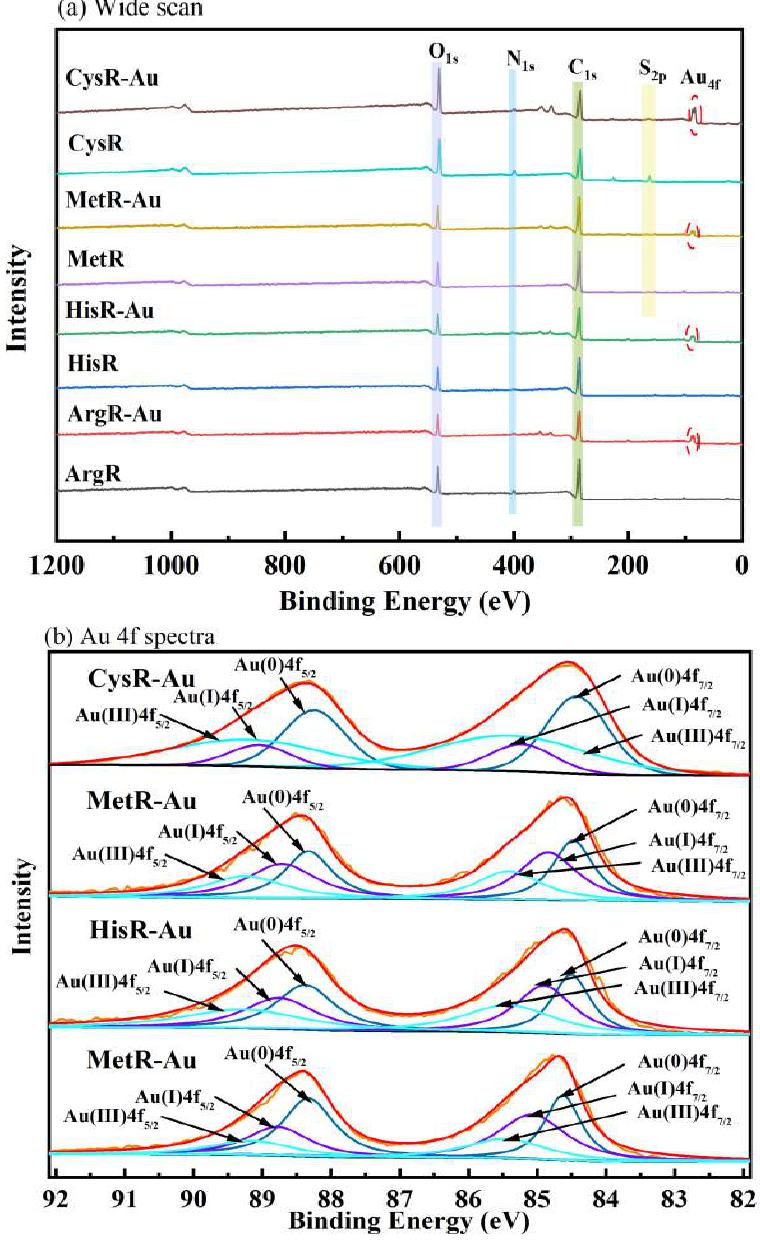
Figure 8. XPS spectra of the amino acid adsorbents before and after adsorption: wide-scan ( a ) and Au4f spectra ( b ).